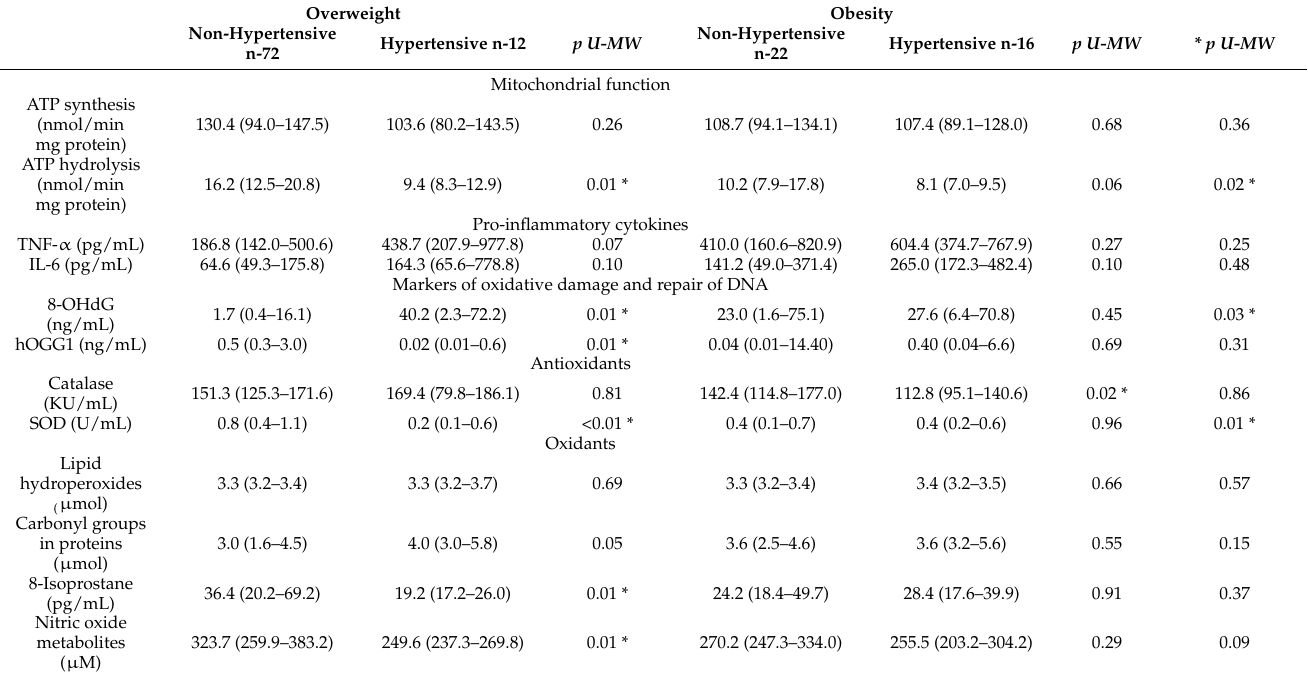
Table 3. Mitochondrial function, oxidative stress markers in hypertensive and non-hypertensive subjects with overweight or